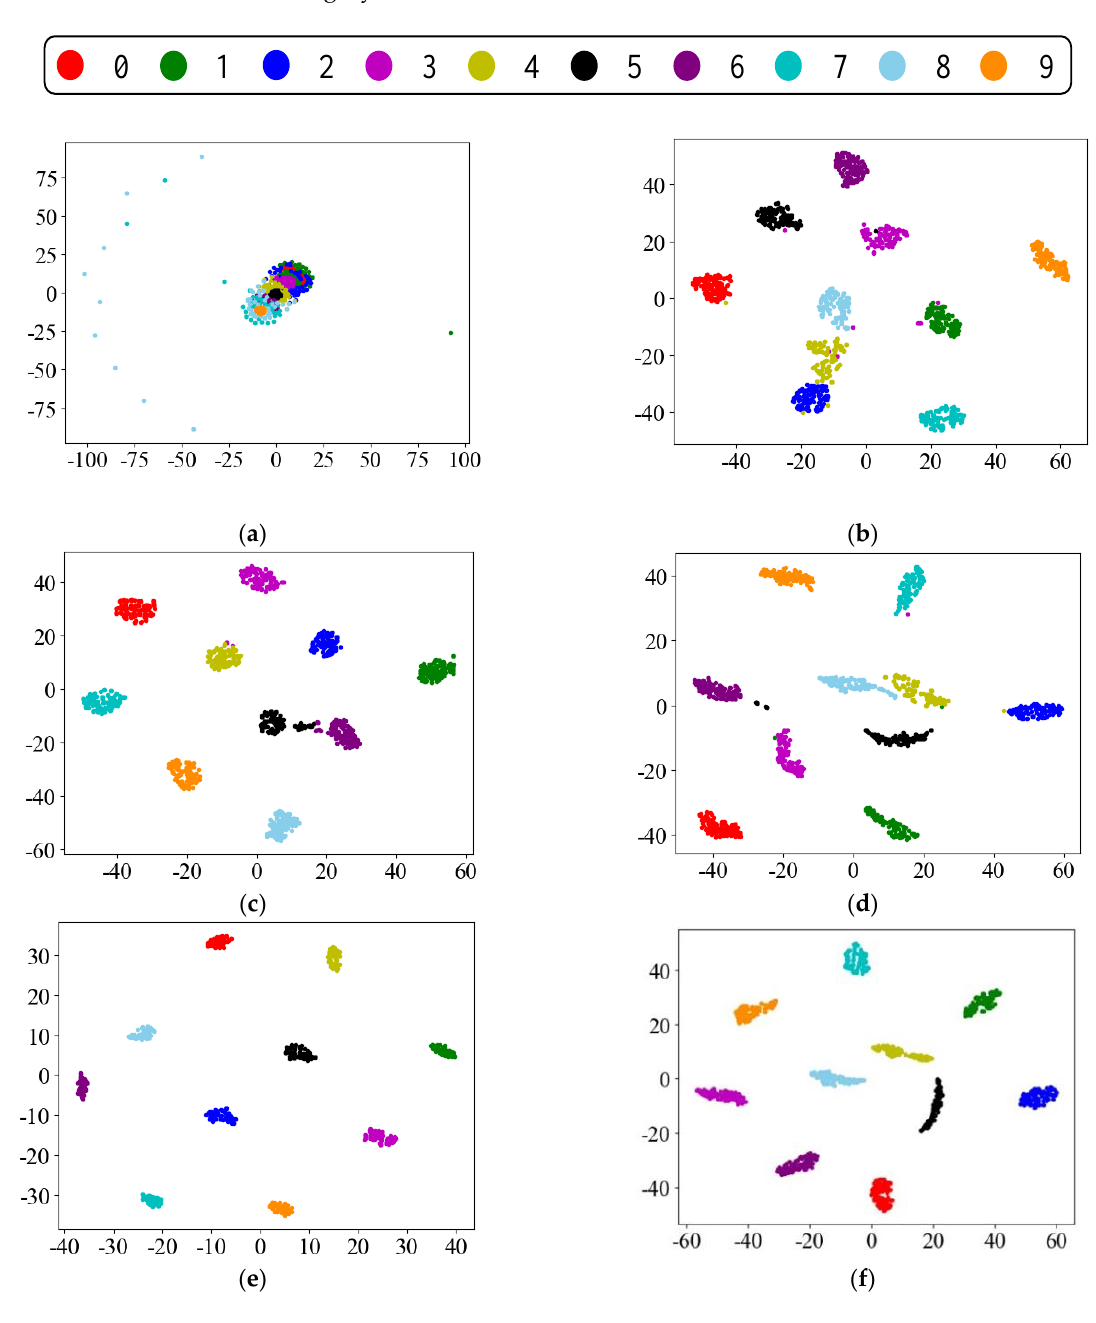
Figure 9. Visualization of the transferable features of task D → C using t-SNE. ( a ) Domain D original sample data; ( b ) CNN; ( c ) CNN + MMD; ( d ) Resnet-50; ( e ) proposed method‑source domain; ( f ) proposed method‑target